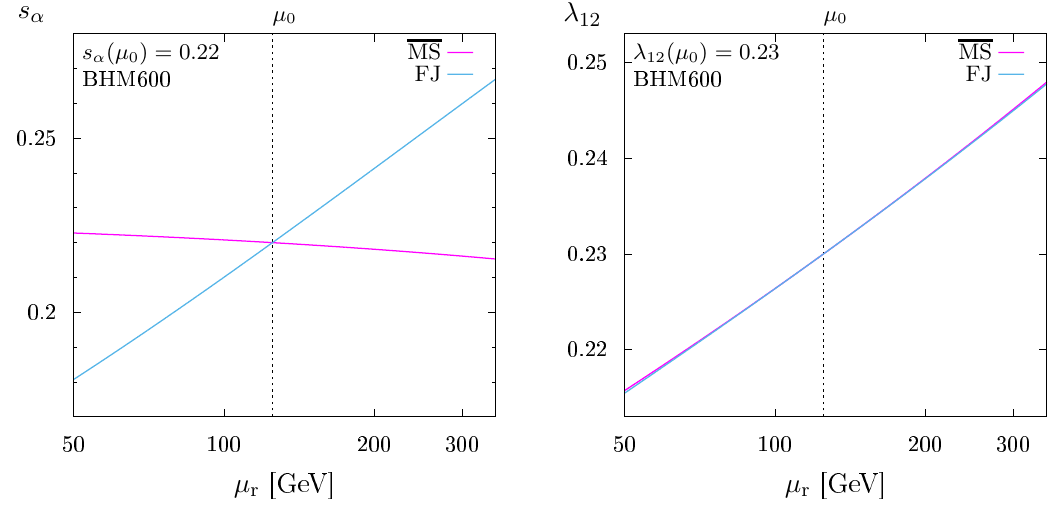
Figure 16 . The running of the input parameters s (cid:11) and (cid:21) 12 in the MS and FJ renormalization schemes for benchmark scenario